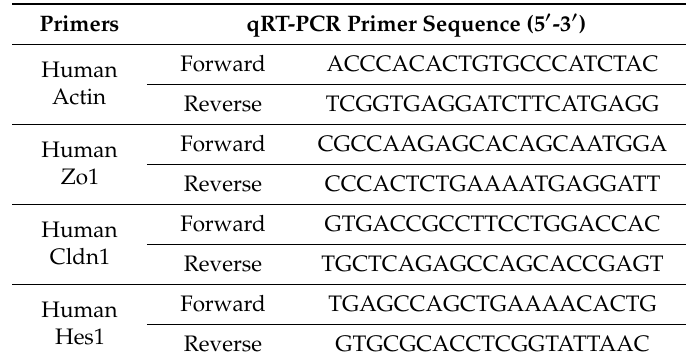
Table 1. Sequencing Information of qRT-PCR